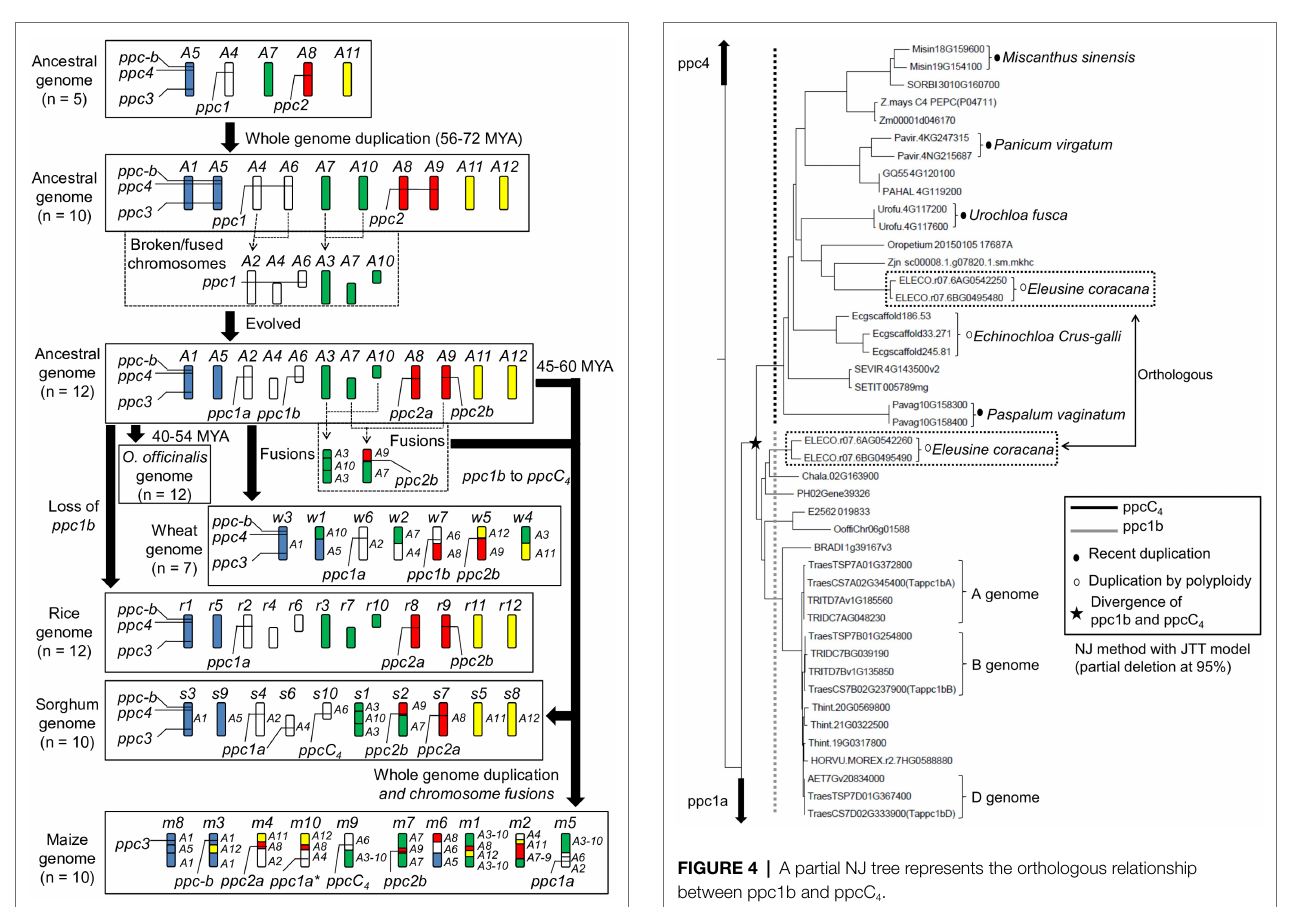
FIGURE 3 | Inferred molecular inheritance of PEPC isogenes in the ancestral grass genome model. The molecular clock information was referred from a study by The International Brachypodium Initiative (2010). The present status of the rice genome, the O. officinalis genome, the wheat genome, the sorghum genome, and the maize genome were also shown. The asterisk represents